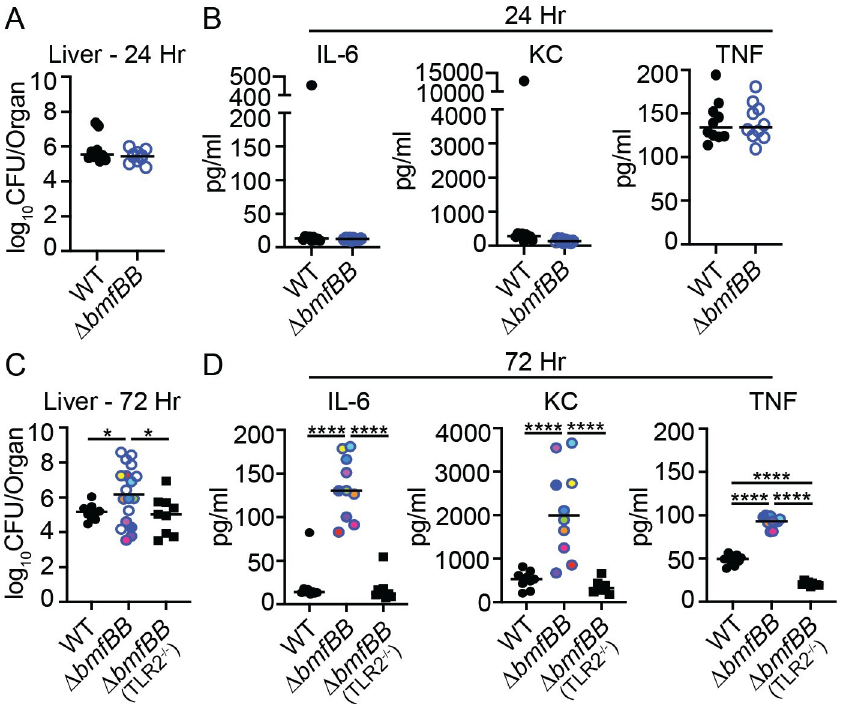
Fig 7. UFAs drive innate immune activation to alter infection dynamics. (A) Bacterial burden (log 10 CFU per organ) recovered from liver 24 hours post-infection with WT or Δ bmfBB mutant S . aureus ( n = 10 per group). (B) IL-6, KC, and TNF levels (pg/mL) in liver 24 hours post-infection with the strains indicated in (A). (C) Bacterial burden (log 10 CFU per organ) recovered from liver 72 hours post-infection of WT mice with WT S . aureus ( n = 10), or WT ( n = 18) and TLR2 -/- ( n = 9) mice with Δ bmfBB mutant S . aureus . (D) IL-6, KC, and TNF levels (pg/mL) in liver 72 hours post-infection. Ten Δ bmfBB liver homogenates were sampled from one of the replicates from (C) and matching colors indicate the cytokine levels from an individual mouse. Graphs represent the combined data of at least two independent experiments. Statistical significance for (C) was determined using a Kolmogorov-Smirnov test and statistical significance for (D) was determined by one-way ANOVA with Tukey’s post hoc test. � P < 0.05; ���� P <